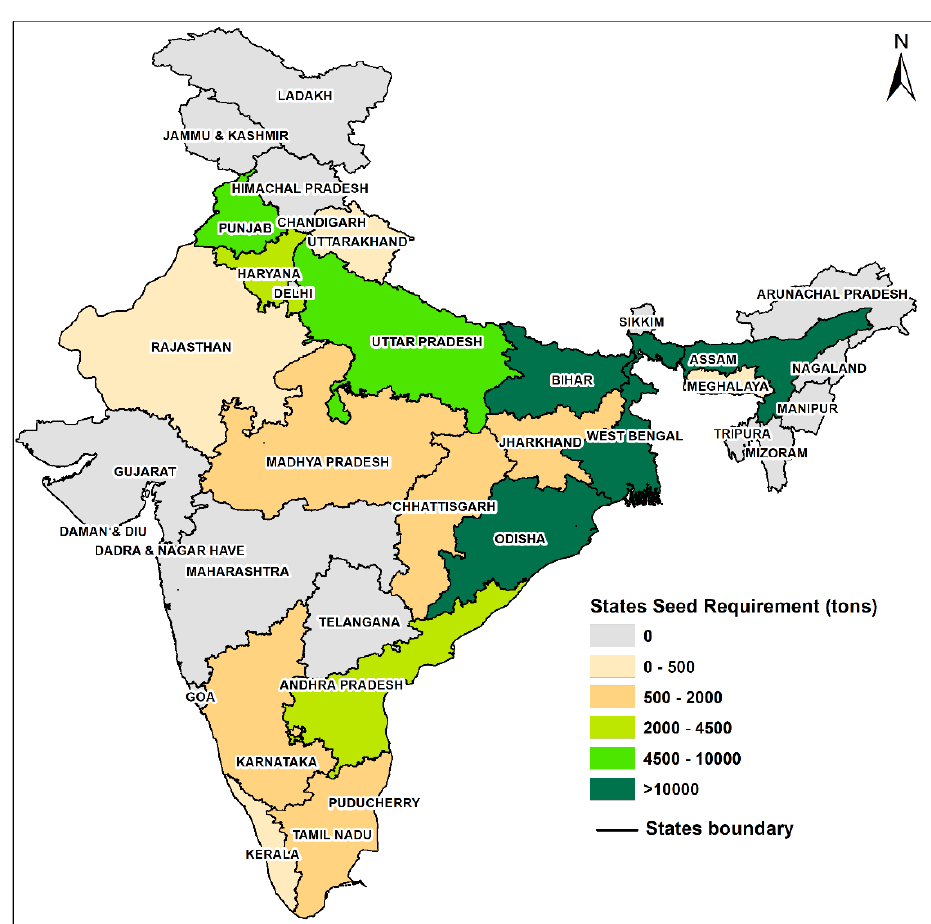
Figure 5. State-wise requirement of Swarna-Sub1 seeds across the study area.